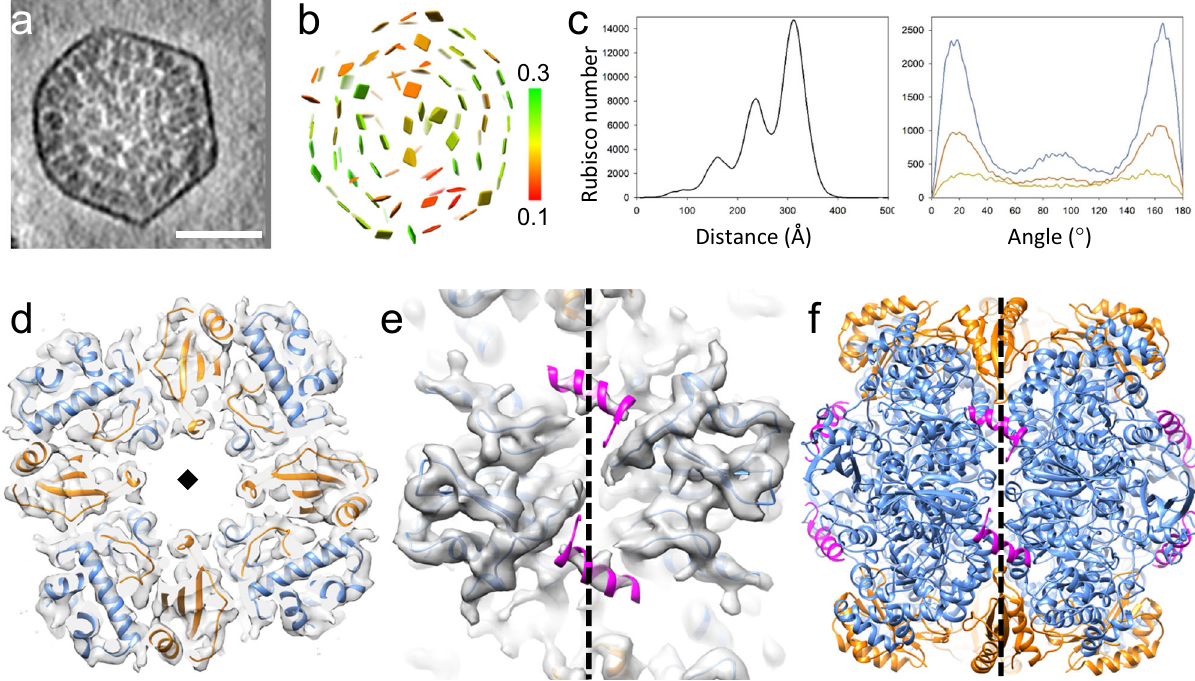
Fig. 1 | Structure and organization of Rubisco within native Cyanobium car- boxysomes. a A tomograms slice (26.8A thickness) of a Cyanobium carboxysome (from n =137). b ThepositionandorientationofindividualRubiscomappedbackto the tomogram of carboxysome, shown as a square plate perpendicular to the fourfold symmetry axis of Rubisco and colored according to the cross-correlation values (0.1 – 0.3, red to blue) between individual Rubisco and the STA map. c Distributions of radial distance (measured from the center, left) and angle (measure from radial direction, right) of Rubisco in Cyanobium carboxysomes.